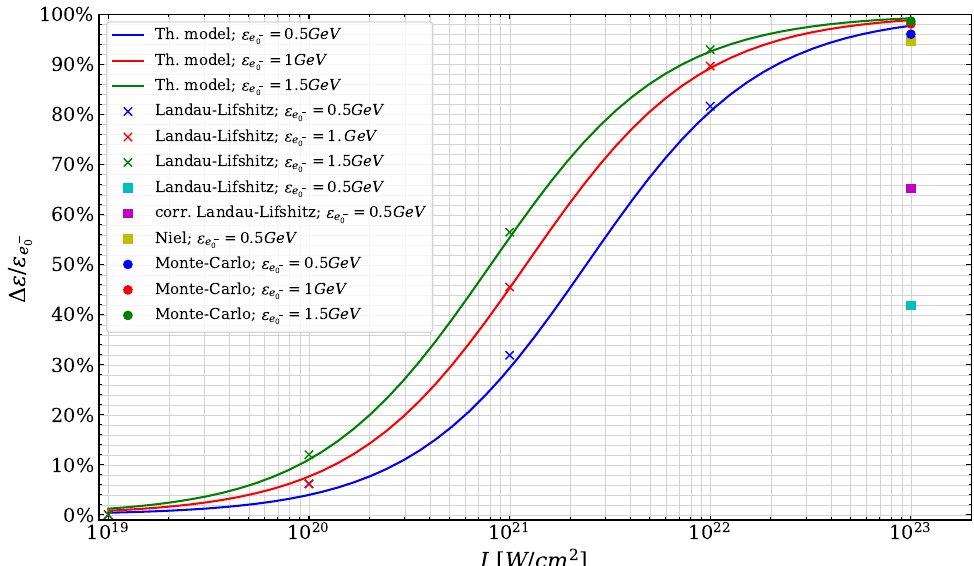
Figure 2. Electron energy loss vs. laser intensity as obtained from 2D PIC simulations. The con- = 0.5 GeV, red— ε = 1 GeV, green— ε = 1 GeV) represent the theoret- tinuous lines (blue— ε e − 0 e − 0 e − 0 ical scaling from Equation (2). The simulation results are represented as follows: the continuous = 0.5 GeV, red— ε = 1 GeV, green— ε = 1 GeV); Landau-Lifshitz model—crosses (blue— ε e − 0 e − 0 e − 0 for I = 10 23 W/cm 2 : continuous Landau-Lifhsitz model—azure square, corrected Landau-Lifshitz model—magenta square, stochastic Niel model—yellow square and stochastic Monte Carlo model— = 0.5 GeV, red— ε = 1 GeV, green— ε = 1 circles (blue— ε e − 0 e − 0 e − 0